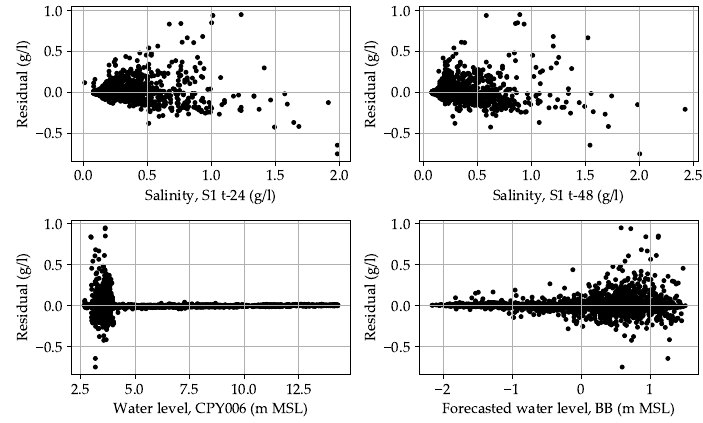
Figure A2. Residuals for the single model candidate 1B.